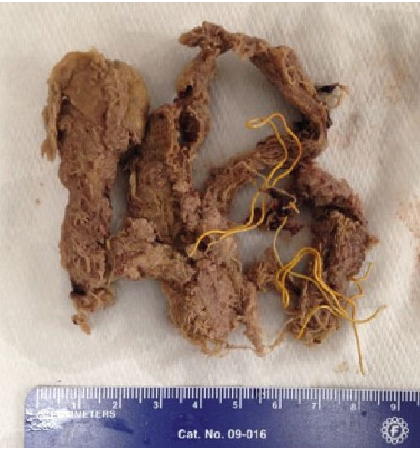
Figure 5: Surgical sponges with yellow radiopaque strings removed from the patient ’ s